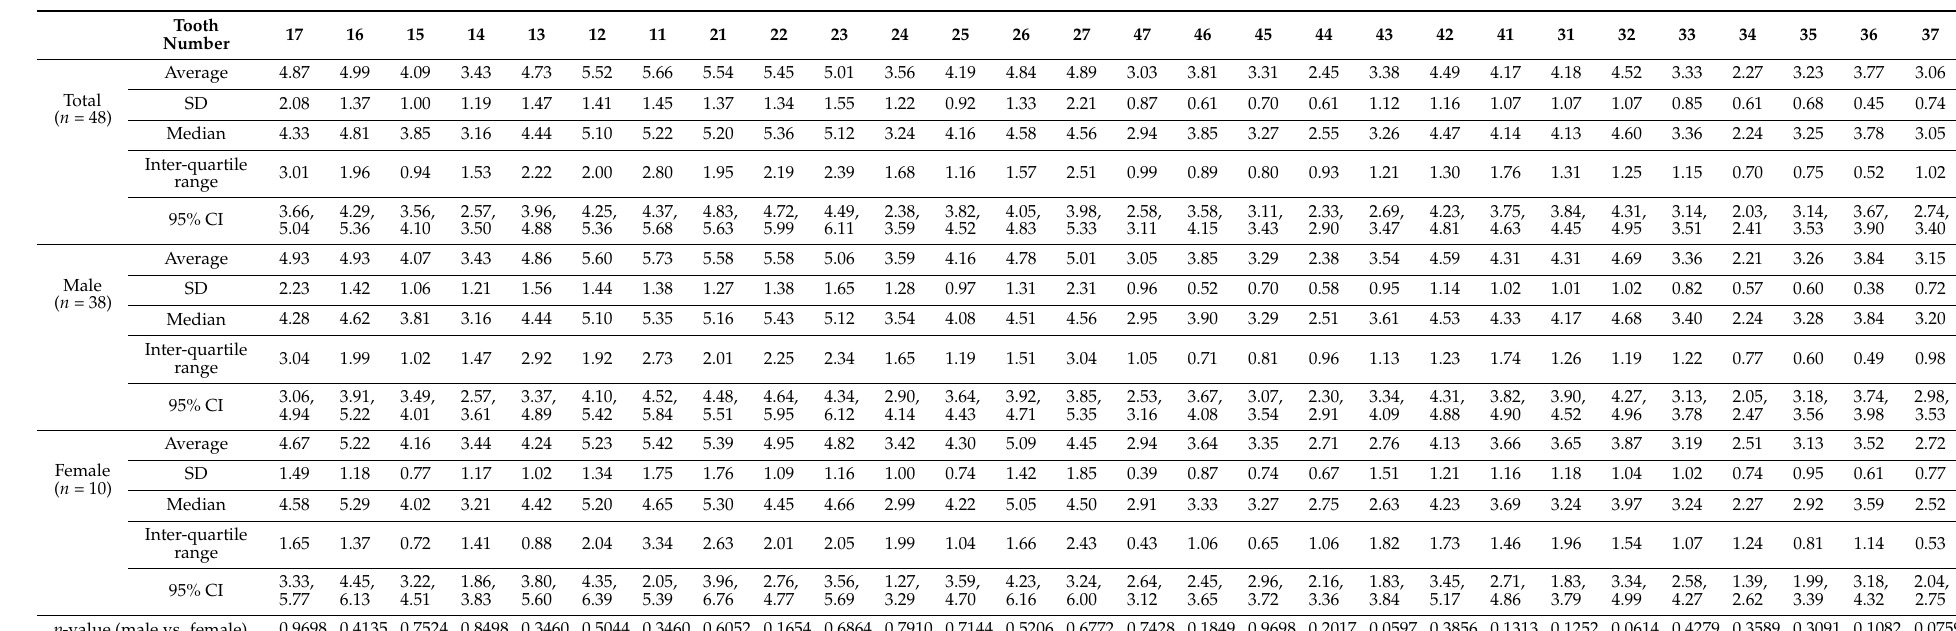
FDI numbering system is used for indicating each